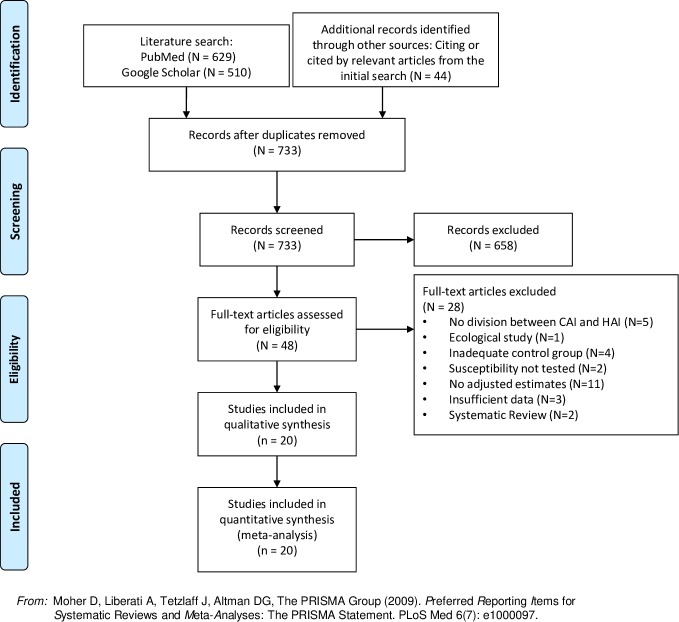
PRISMA flow diagram.